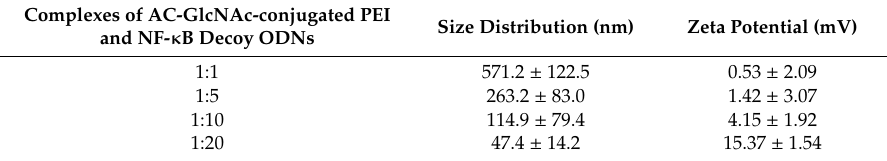
Table 2. Size distribution and zeta potential of complexes of AC-GlcNAc-conjugated polyethyleneimine (PEI) and NF- κ B decoy oligonucleotides